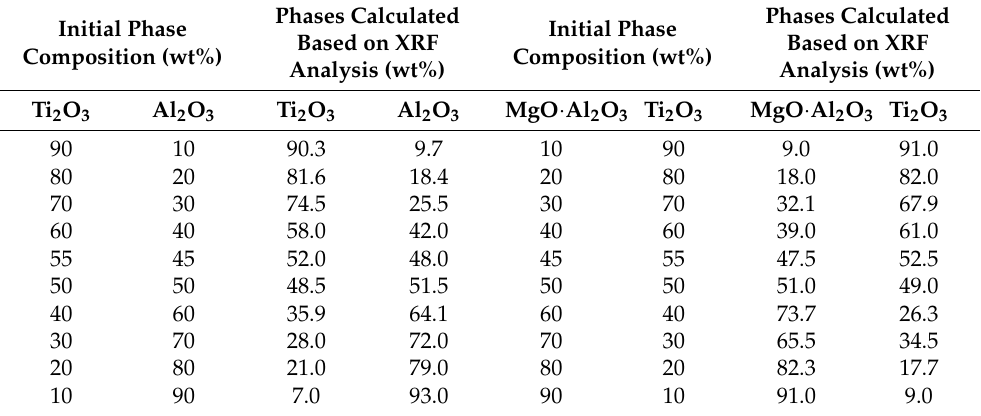
Table 1. Prepared sample composition and XRF analyses obtained from binary phases of Ti 2 O 3 –Al 2 O 3 and Ti 2 O 3 –MA.